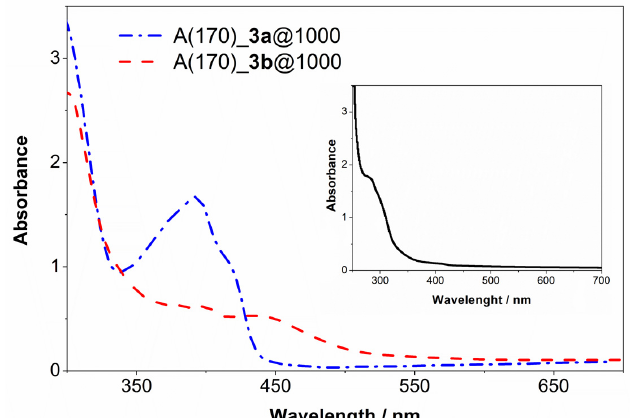
Figure 9. UV/Vis spectra of A(170)_ 3a @1000 and A(170)_ 3b @1000 OIH matrices normalized to the film’s thickness. The UV/Vis spectra of pure films are included in the inset.